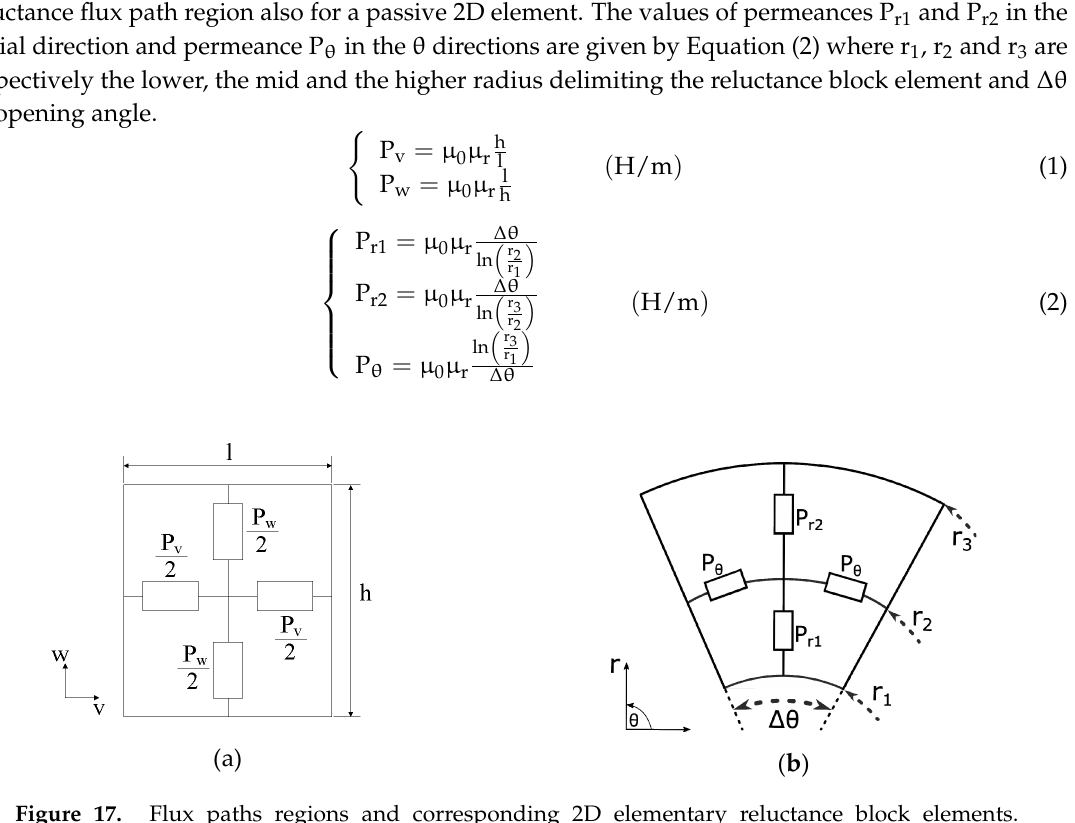
Figure 17. Flux paths regions and corresponding 2D elementary reluctance block elements. ( a ) Parallelepiped bidirectional reluctance block element; ( b ) cylindrical bidirectional reluctance block element.